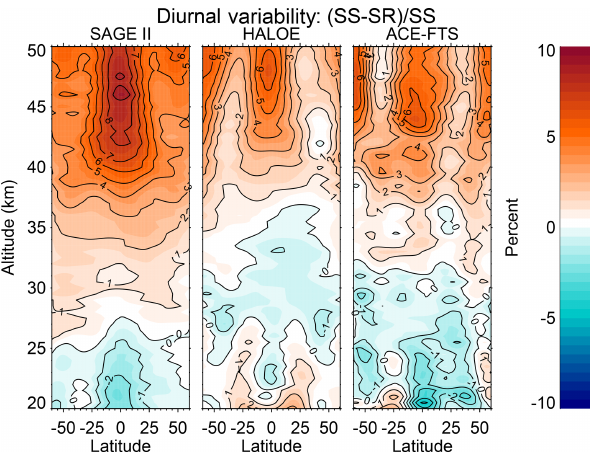
Figure 3. Results from the regression depicting the mean diurnal variability present in each data set plotted as the percent difference between sunrise and sunset events. These results compare well with those of Sakazaki et al.